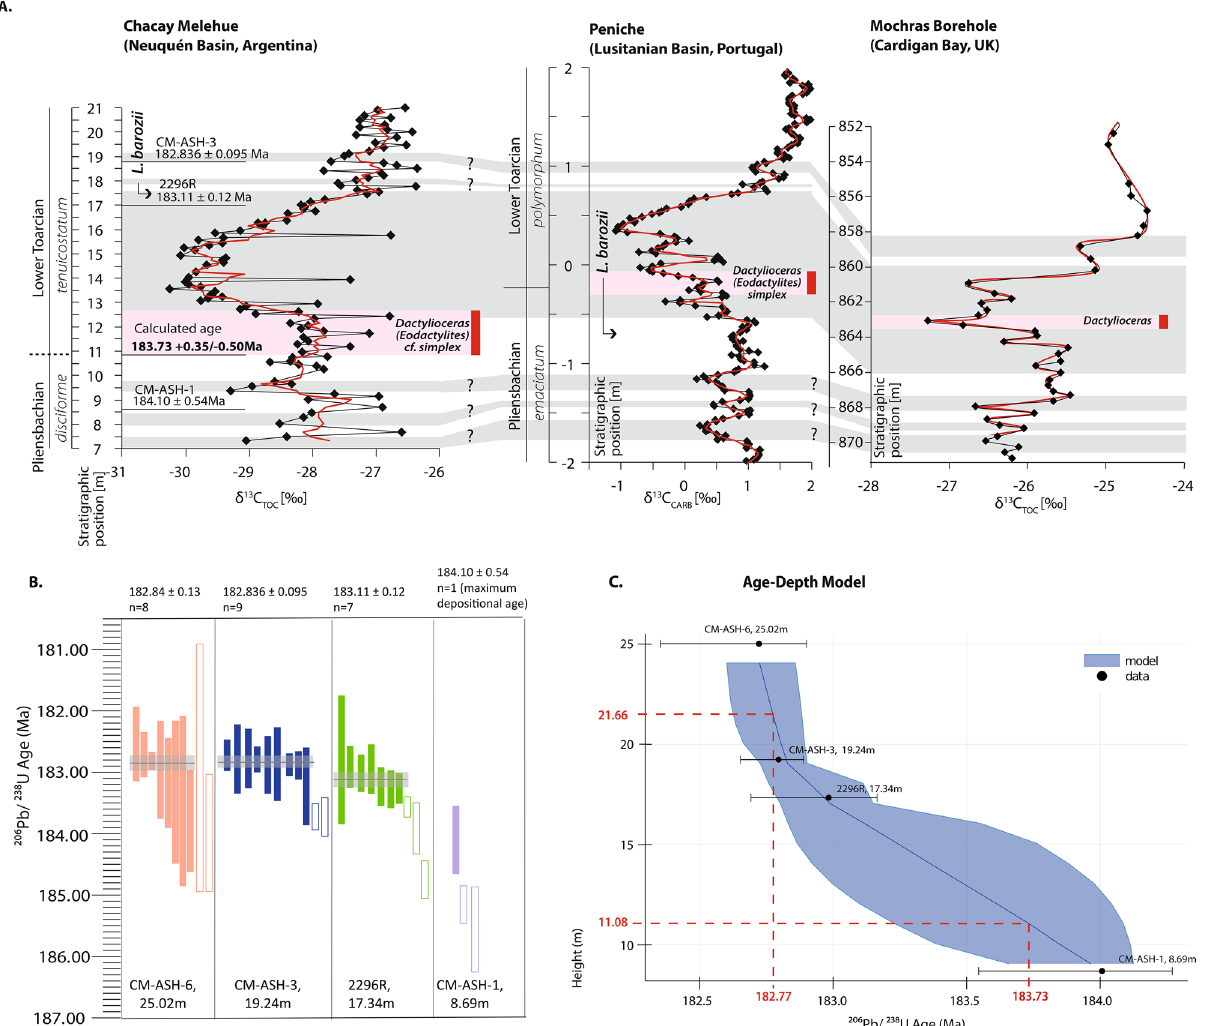
Figure 3. ( A ) Detailed comparison of Chacay Melehue geochronology, carbon-isotope chemostratigraphy and the lowest and first occurrence (FO) of Dactylioceras (indicated by the horizontal pink band and vertical red bar) as compared with the GSSP at Peniche, Portugal 3,6 and in the Mochras borehole, UK 58 . Grey bands highlight chemostratigraphic correlation intervals between the two localities. Pink bands highlight the occurrence of key ammonites of latest Pliensbachian and Early Toarcian age in the sections. Red line shows 2 pt. moving average ( B ) Shows the distribution of zircons from individual ash bed units in the Chacay Melehue stratigraphic section. Open rectangles indicate ages considered detrital and not used to determine the mean age or in the Age-Depth model. ( C ) Age–depth model for Chacay Melehue showing the Bayesian distribution of the ages and the modelled age estimates. The red dashed line and emboldened red numbers indicate the modelled age for the Pliensbachian–Toarcian boundary at 11.08 m, with a modelled age of ~ 183.73 + 0.35/-0.50 Ma, and for the tennuicostatum – hoelderi zonal boundary (equivalent to the tenuicostatum – serpentinum zonal boundary) at 21.66 m, with a modelled age of ~ 182.77 + 0.11/-0.15